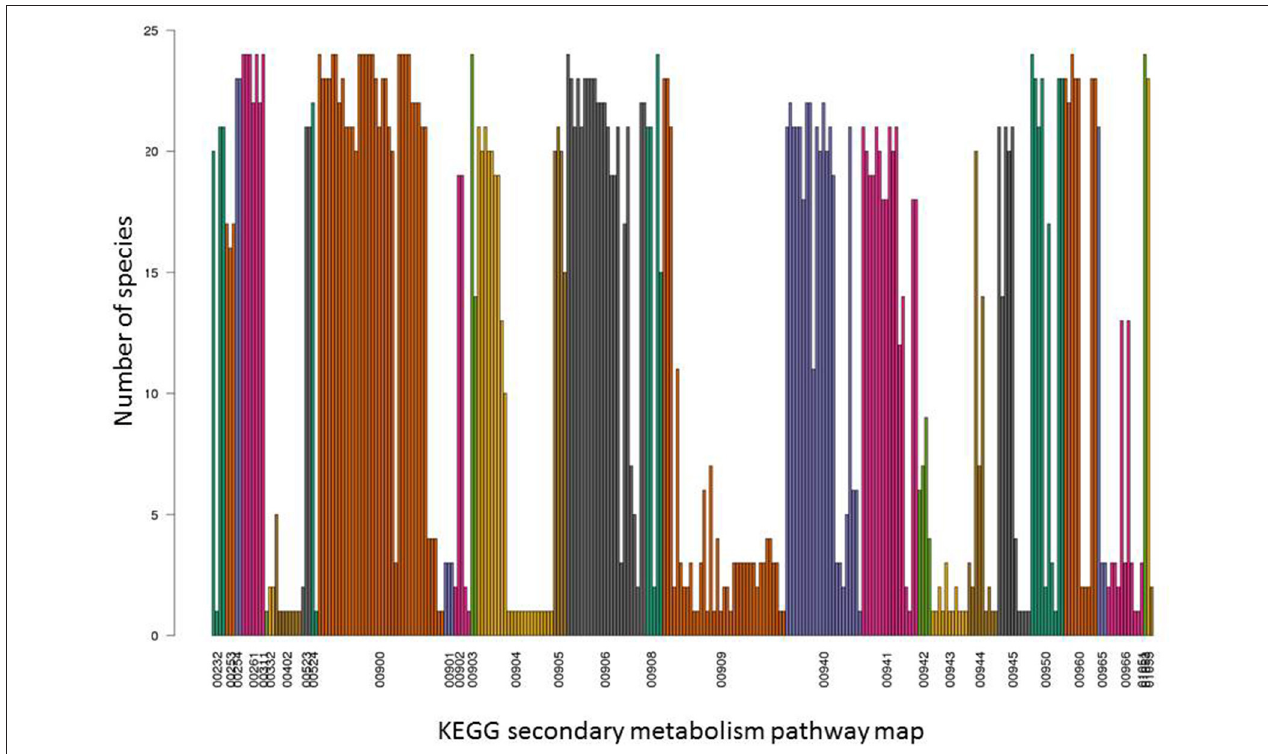
FIGURE 2 | Detailed occurrence profiles of secondary metabolite pathways. For all 31 KEGG secondary metabolite pathways indicated by their KEGG map number, presence across the 24 plant species used in this study is plotted for their respective constituent enzymes. Each bar represents one pathway enzyme and their presence across 24 plant species based on identical EC number annotation in the different species. Enzymes are grouped and colored according to their KEGG map number. For associated pathway names, see Figure 1